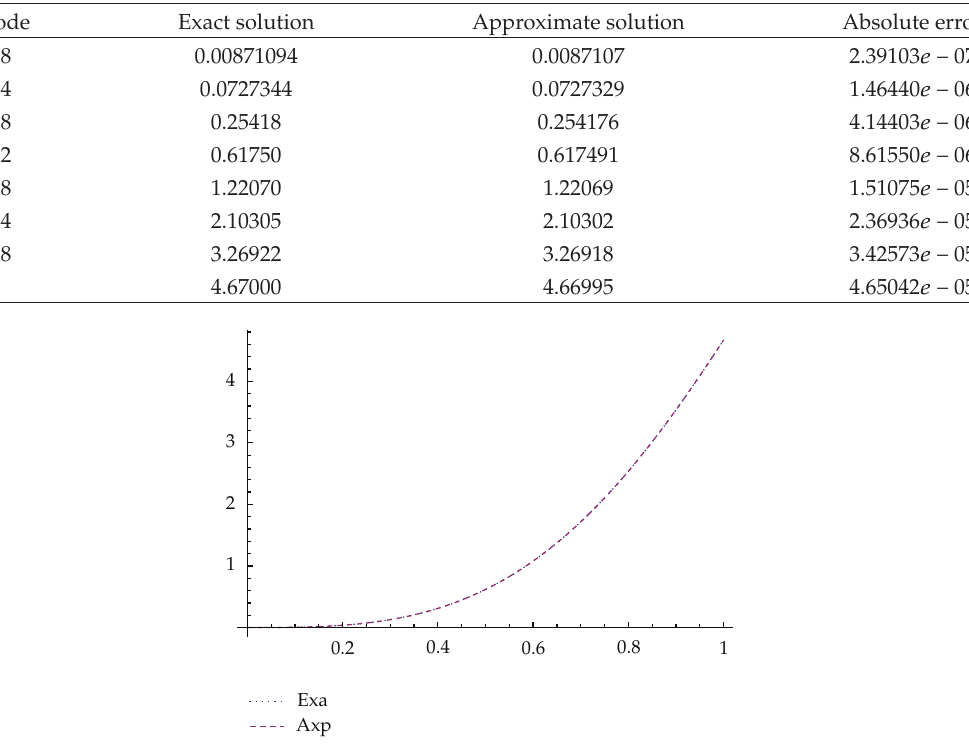
Table 1: Numerical results for n (cid:9) 128 for Example 4.1.